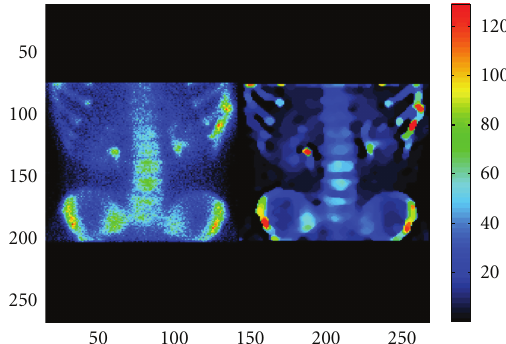
Figure 3: Bone scintigraphy: a standard scintigraphic image (left image) is restored with the use of Compton-scattered radiation. Hot spots or nodule are clearly displayed (right image—reprinted with permission from